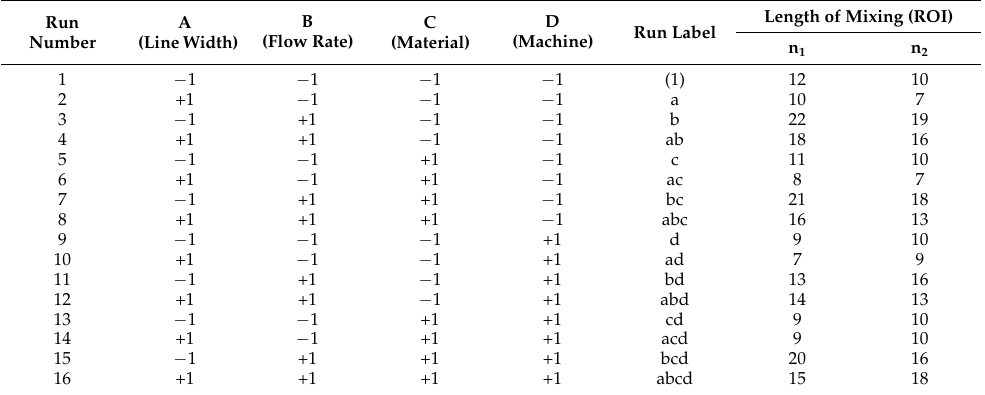
Table 3. The performance of mixing in each FFF printed micromixer, evaluated by colorimetric analysis. Run